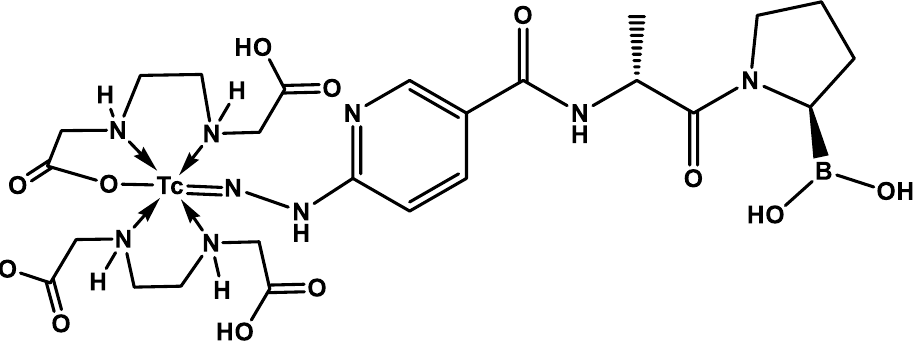
Figure 9. The proposed [Tc(V)]EDDA/HYNIC core structure in the [ 99m Tc]Tc-iFAP radioligand. The advantage that HYNIC-iFAP presents with respect to previously reported quinolinoyl- cyanopyrrolidine-based FAP inhibitors is the possibility of obtaining [ 99m Tc]Tc(V)-EDDA/HYNIC stable cores from instant freeze-dried kit